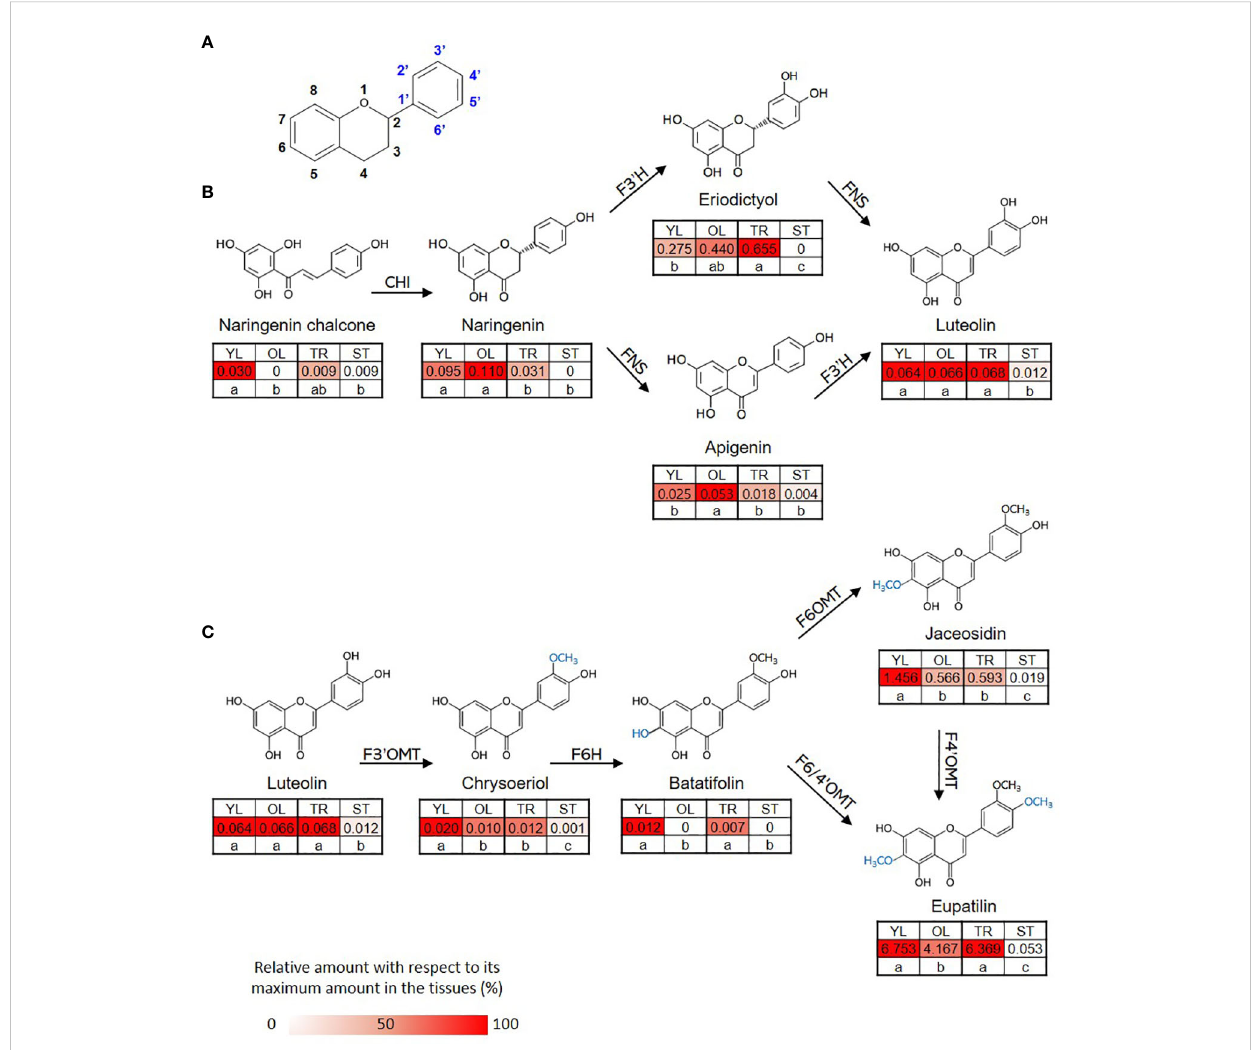
FIGURE 3 Proposed biosynthetic pathway for eupatilin and jaceosidin. (A) Basic structure of fl avone. (B) Previously established biosynthetic pathway towards fl avone basic skeletons, apigenin and luteolin. CHI; Chalcone- fl avanone isomerase, FNS; Flavone synthase, F3´H; Flavanone-3´-hydroxylase. (C) Proposed remaining steps for eupatilin and jaceosidin biosynthesis starting from luteolin. F3 ’ OMT; Flavonoid-3´- O -methyltransferase, F6H; Flavone-6-hydroxylase, F6OMT; Flavonoid-6- O -methyltransferase, F6/4 ’ OMT; Flavonoid- 6/4´- O -methyltransferase. Hydroxylation and O -methylation by corresponding enzymes are shown in blue. YL represents young leaves, OL represents old leaves, TR represents trichomes, and ST represents trichome-removed stem. Numbers in the heatmap boxes represent the measured amount of the metabolite in mg/g dry weight of sample. The heatmap represents the relative abundance of the metabolite in each tissue as a percentage, relative to its maximum amount detected in any tissue. Different letters within rows indicate signi fi cant difference based on one-way ANOVA and Tukey ’ s HSD test ( n =3, p <